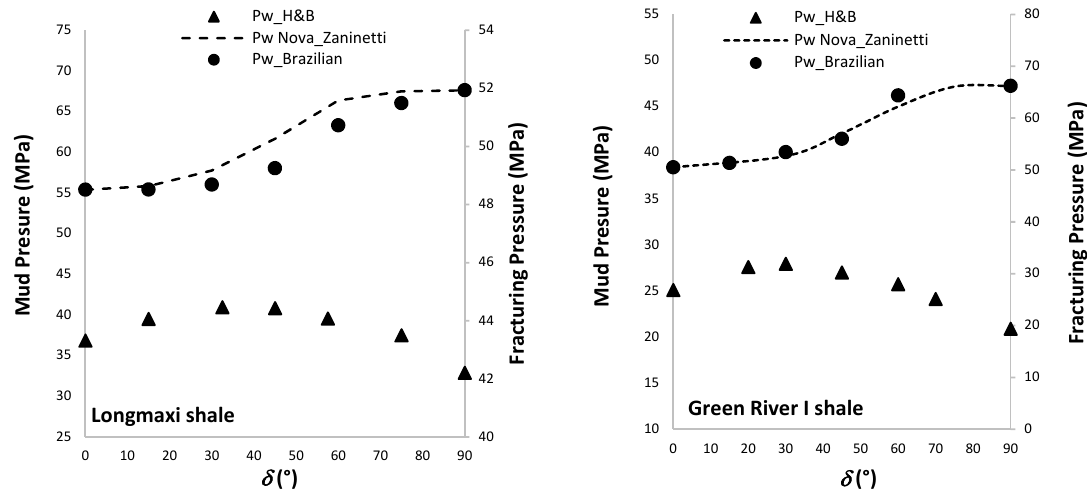
Figure 17. Variation of the fracturing pressure and mud pressure to avoid slip with δ . The pressures were calculated with the following in situ state of stress: σ MAX = 70 MPa, σ min = 50 MPa, P f = 35 MPa.